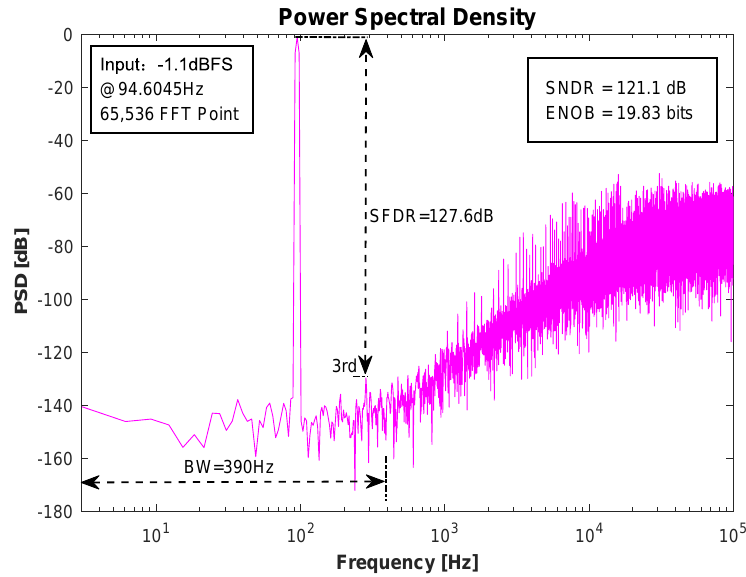
Figure 14. Simulated power spectral density (PSD) of the proposed ADC.